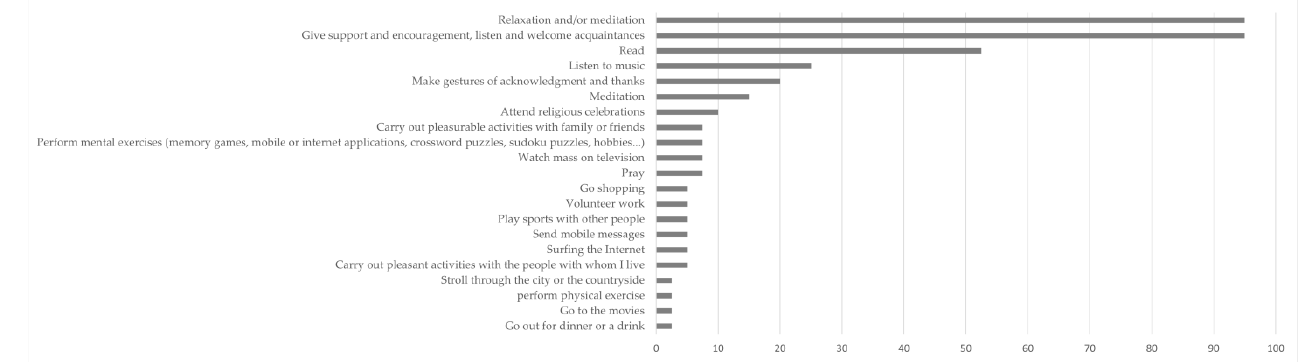
Figure 2. Percentage of people who have started doing the task as a result of the pandemic.